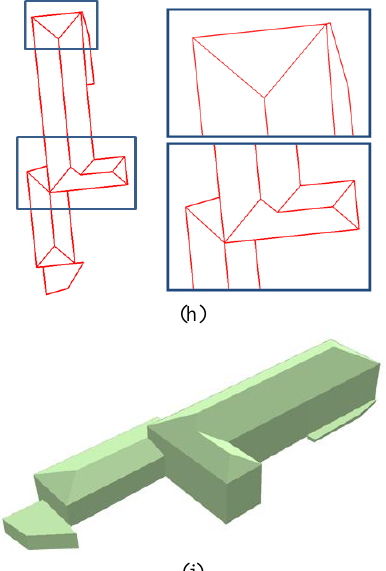
Figure 3. Results in reconstructing an optimal rooftop model: (a) aerial image, (b) LiDAR data, (c) height clustering, (d) plane clustering, (e) intersection line extraction, (f) step line extraction, (g) BSP-based building reconstruction with distortion errors indicated as arrows, (h) MDL-based shape regularization, and (i) 3D polyhedral building model.